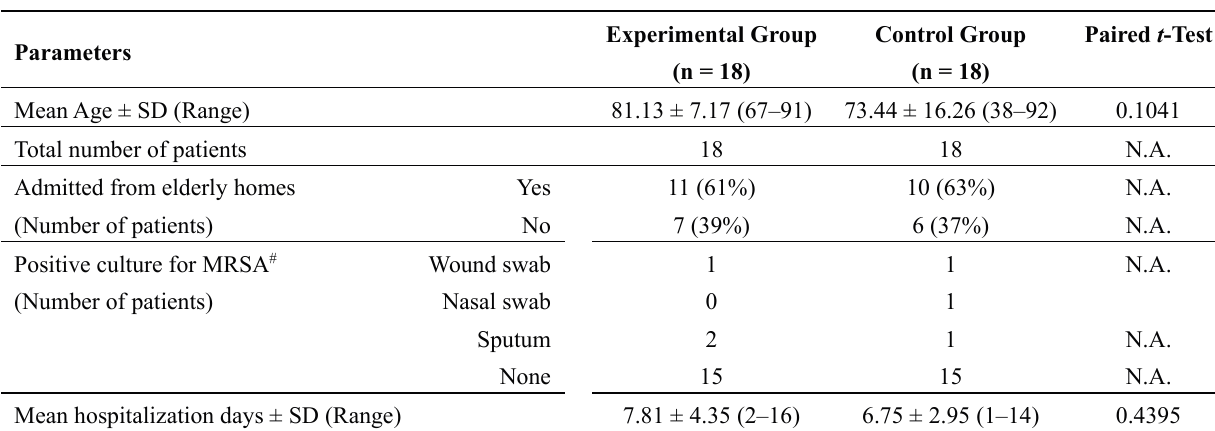
Table 1. Demographic characteristics of patients who occupied the bed-units in the experimental and control